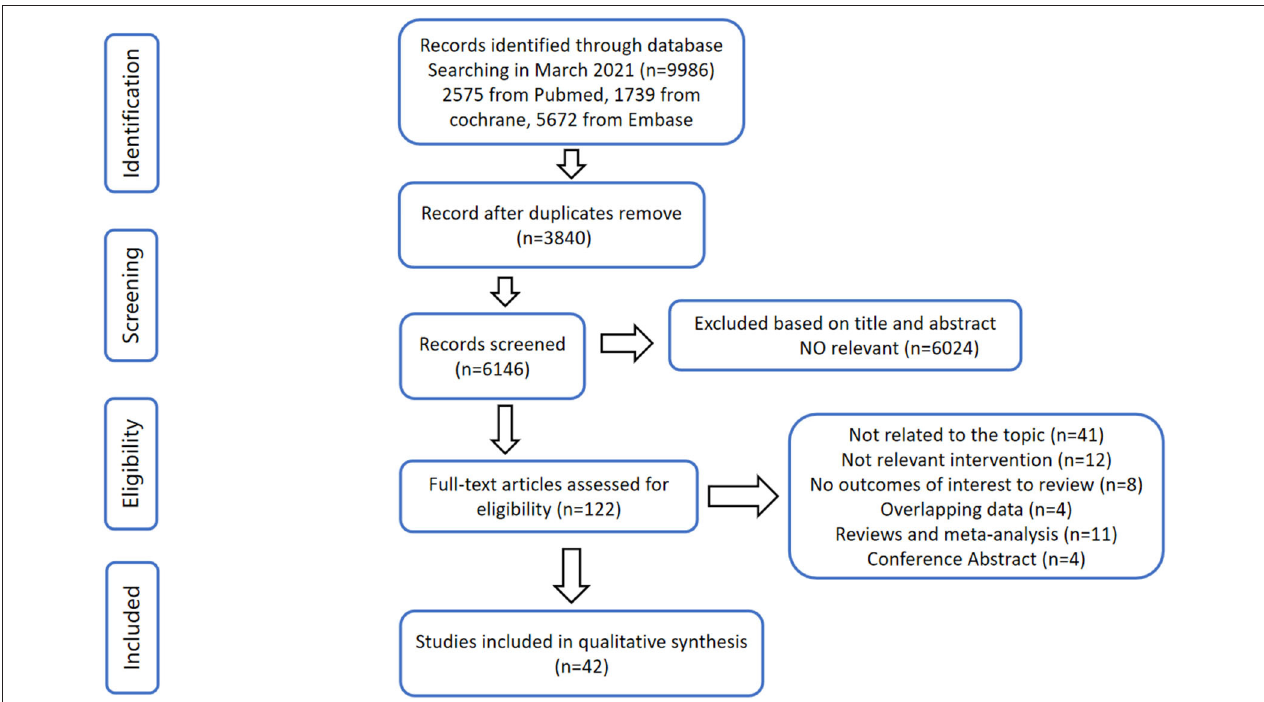
FIGURE 1 | Flow diagram according to the preferred reporting items for systematic reviews and meta-analyses (PRISMA) protocol.